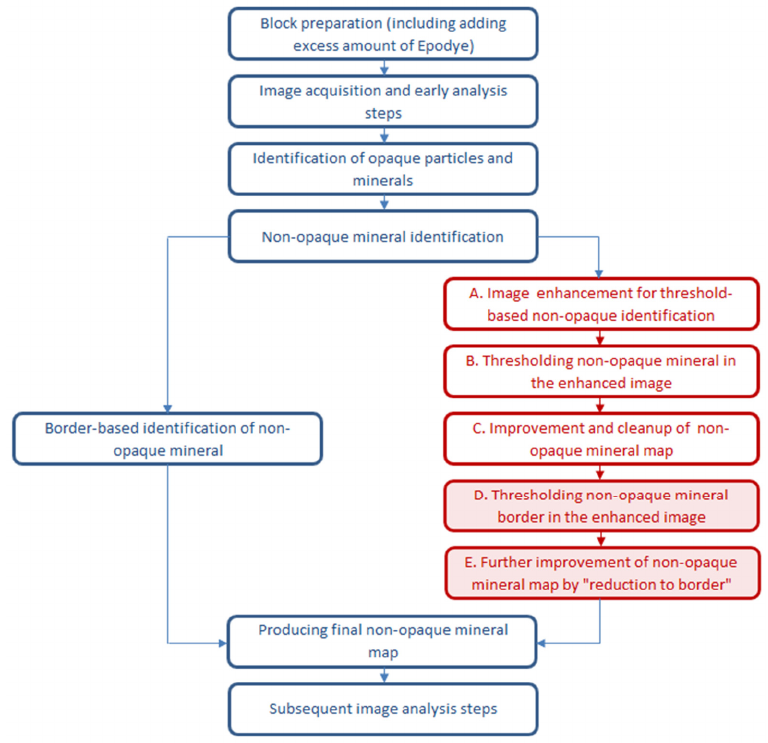
Figure 3. Enhanced threshold-based identification of non-opaque minerals (red) within Mineral5 workflow. Optional “reduction to border” steps highlighted with pink.